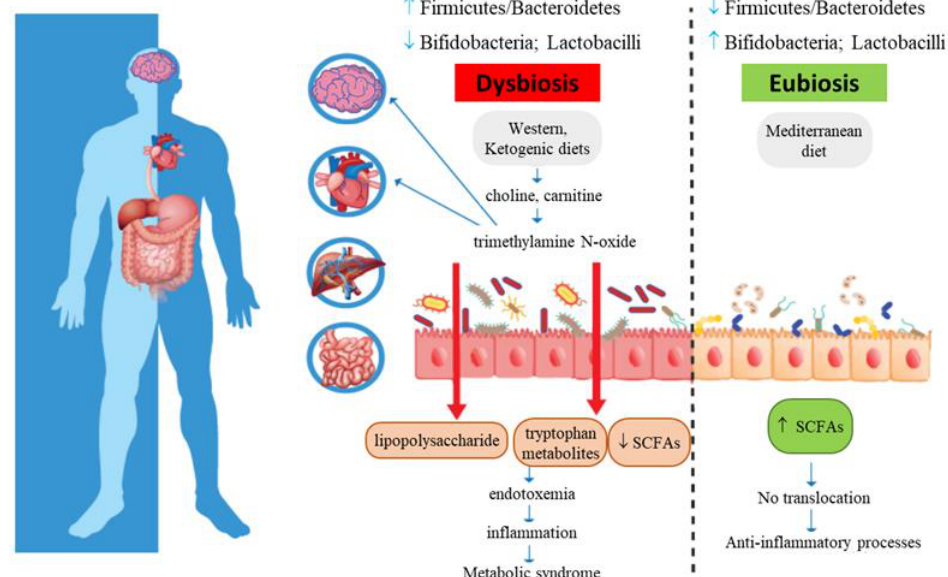
Figure 2. Metabolic syndrome and gut microbiota intestinal dysbiosis. Increased intestinal permeability causes translocation of lipopolysaccharide and tryptophan-derived metabolites, with subsequent metabolic endotoxemia and chronic low-grade systemic inflammation.